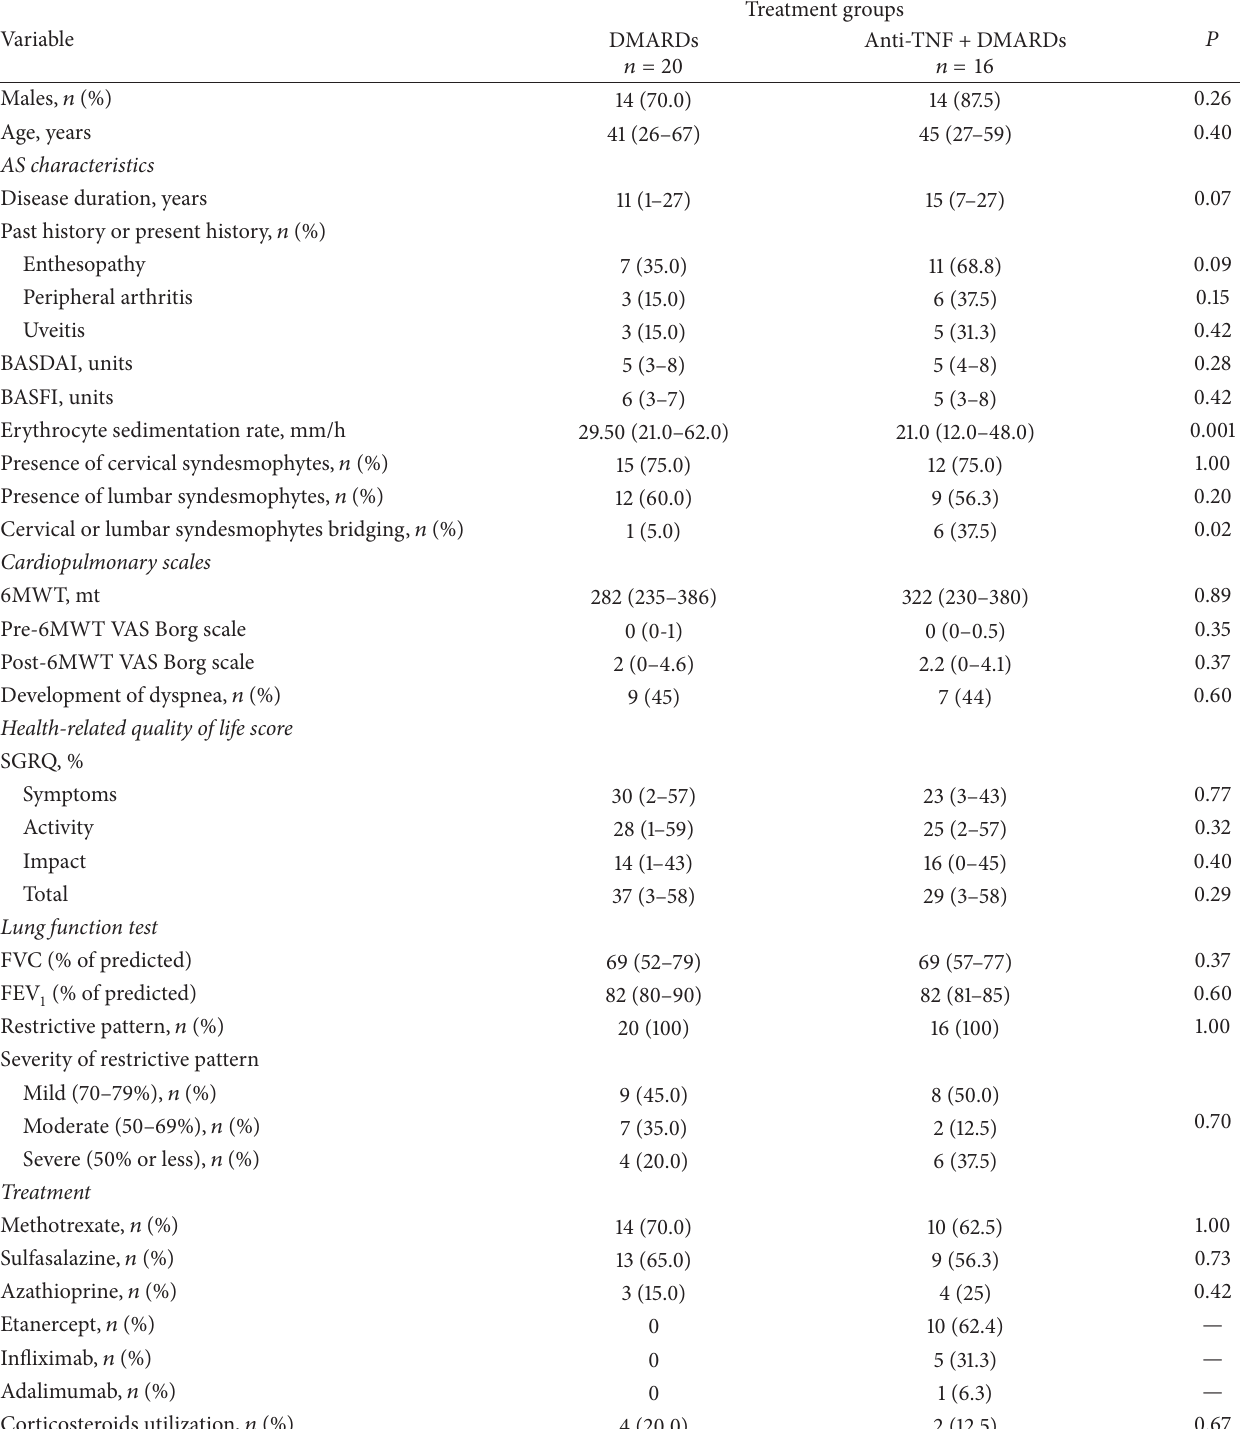
Table 1: Comparison of selected variables at baseline between treatment